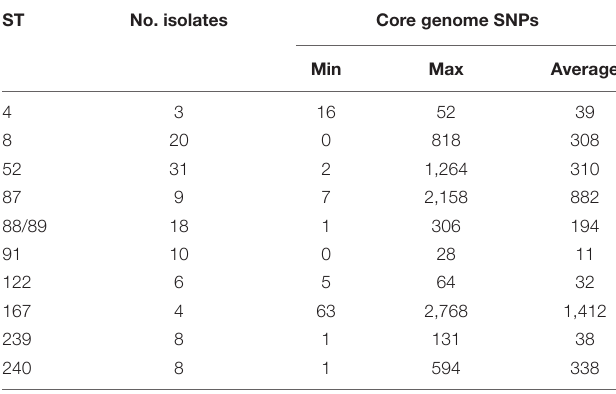
TABLE 1 | Core genome SNPs within STs found in 115 UK isolates, for STs with > 2 isolates present.